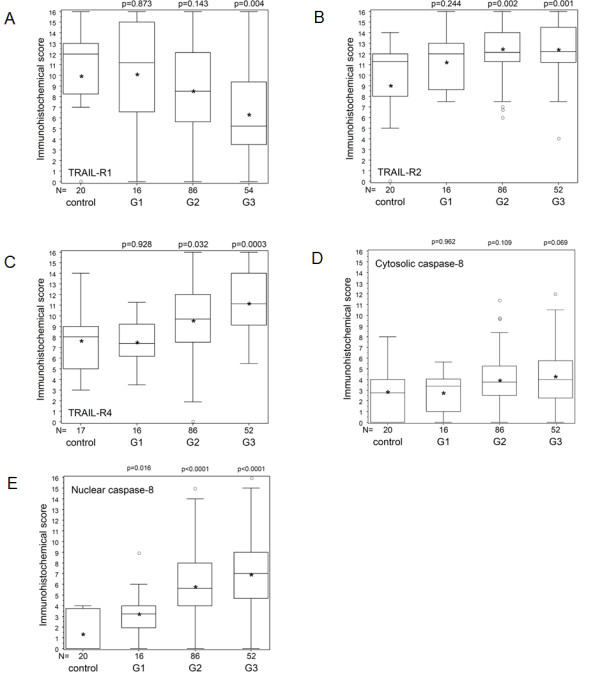
Protein expression levels and WHO grade of malignancies. Expression of TRAIL-R1 (A), TRAIL-R2 (B), TRAIL-R4 (C), cytosolic caspase-8 (D), and nuclear caspase-8 (E) expression in HCC specimens according to tumor grading compared to normal liver tissue. Statistical analysis was performed by the Wilcoxon test. Statistical significance is indicated for all tumor grades in comparison to healthy liver controls.